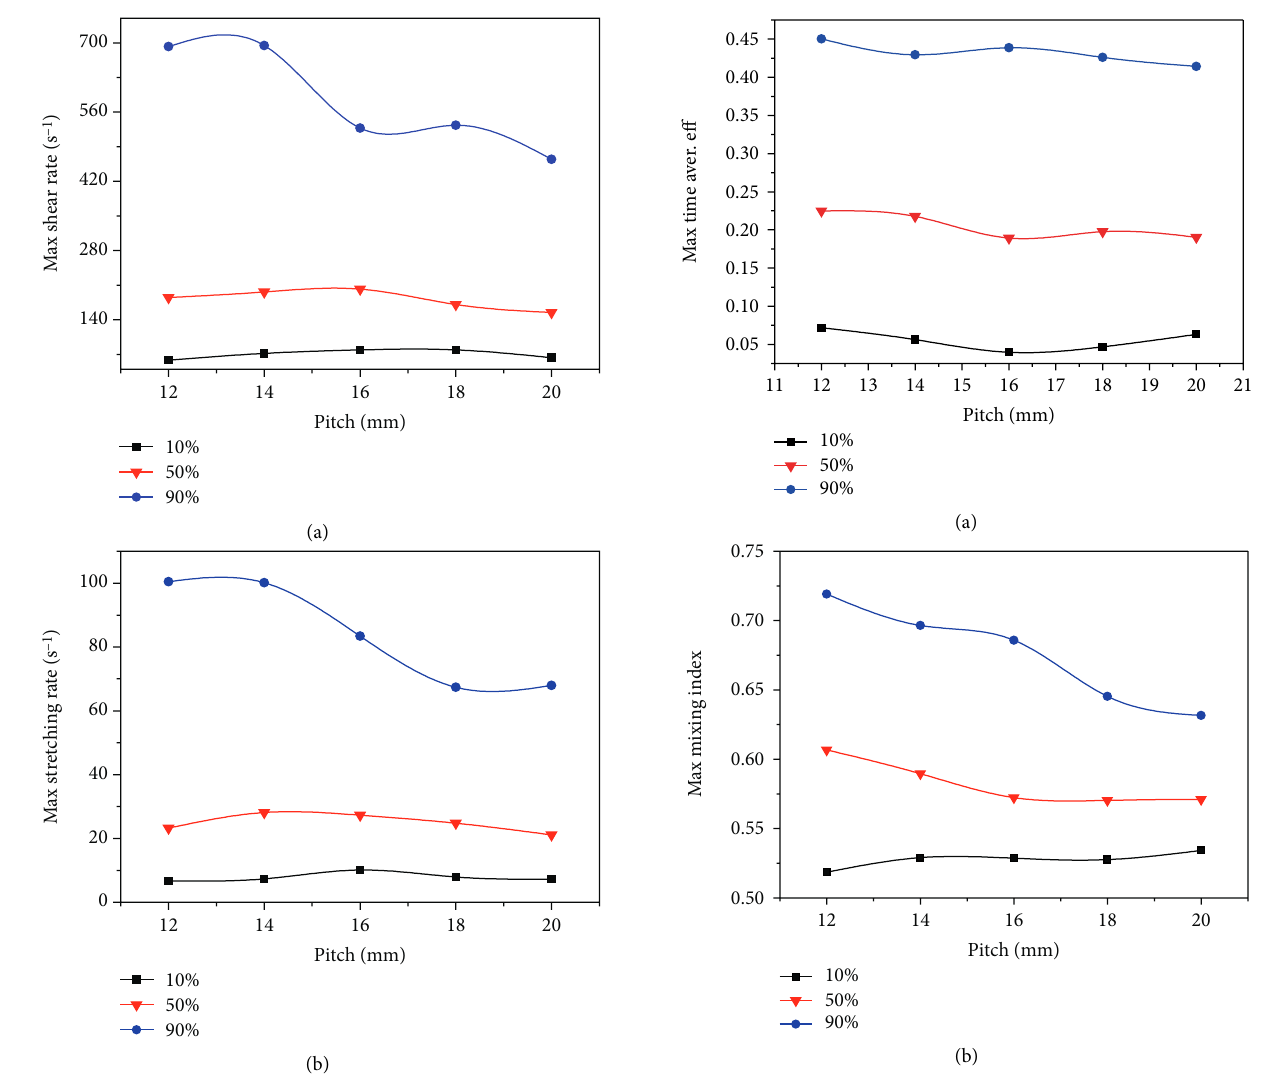
Figure 13: Influence of rotor pitch on the maximum shear rate (a) and stretching rate (b).